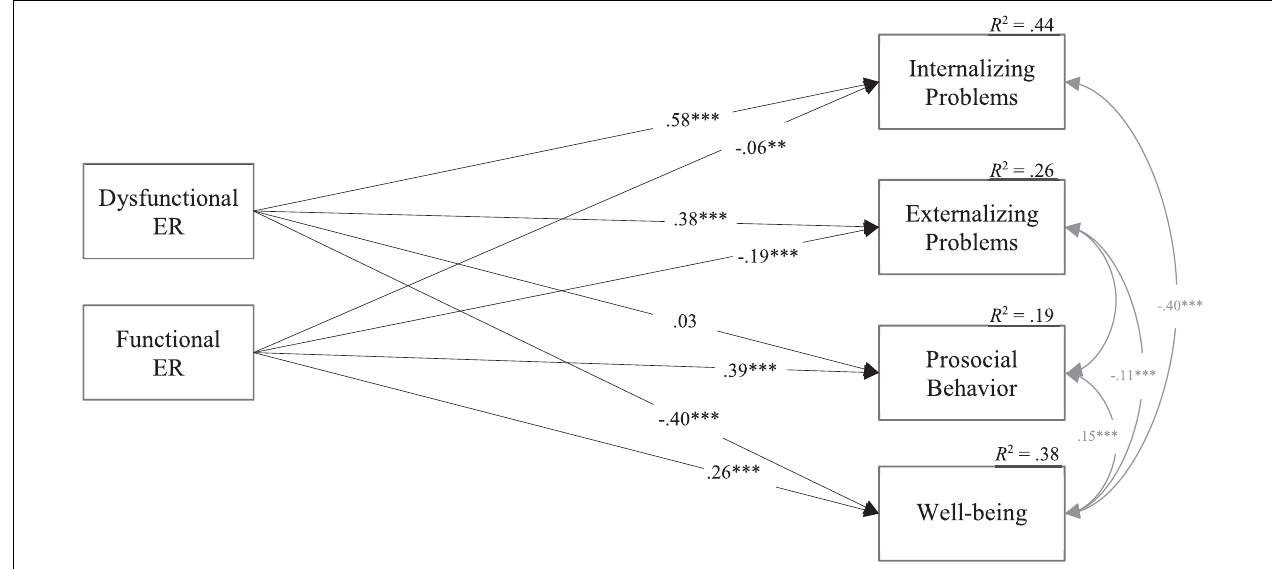
FIGURE 1 | General associations of emotion regulation with psychosocial adjustment and well-being (Model 1). This path model shows general associations of adolescents’ functional and dysfunctional emotion regulation, measured by the secondary subscales of the POEM-CA, with their psychosocial adjustment (SDQ) and well-being (KIDSCREEN). For reasons of simplification, associations with age and sex (covariates), and inter-correlations of the independent variables are not displayed. Statistics are standardized correlation and regression coefficients. N = 1,727. χ 2 = 12.220, df = 2, CFI = 0.996, RMSEA = 0.054, SRMR = 0.009. ∗∗ p < 0.01; ∗∗∗ p <